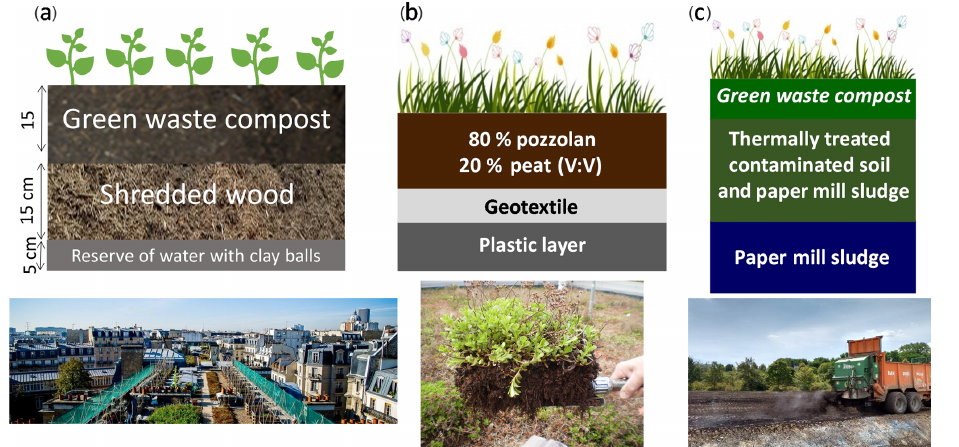
Figure 4. Examples of the organization of horizons in constructed Technosols noted in the literature for (a) green roof (Grard et al., 2018), (b) green roof (Bouzouidja et al, 2018), and (c) abandoned land (Séré et al., 2010). Note: (V:V) –